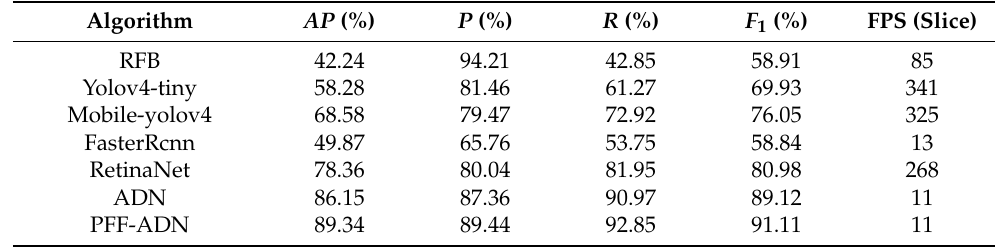
Table 4. Effectiveness of different